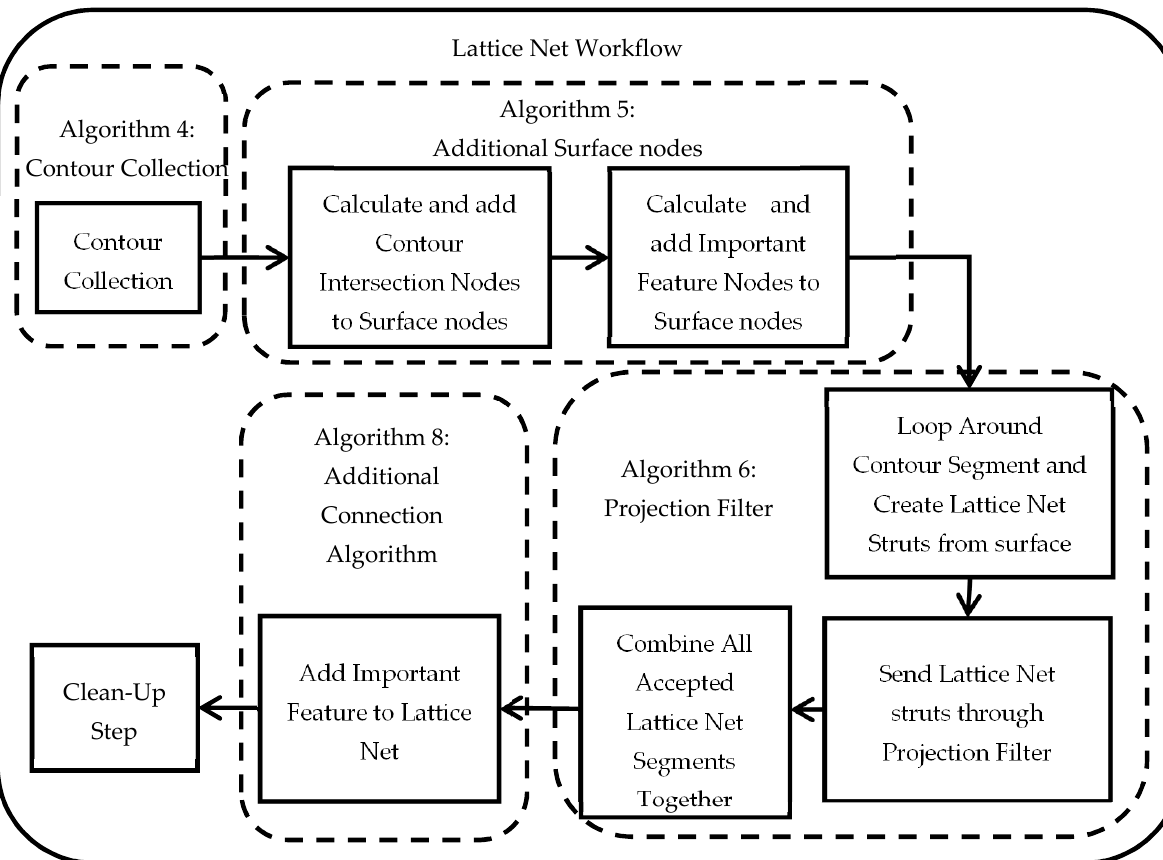
Figure 7. Lattice net workflow.